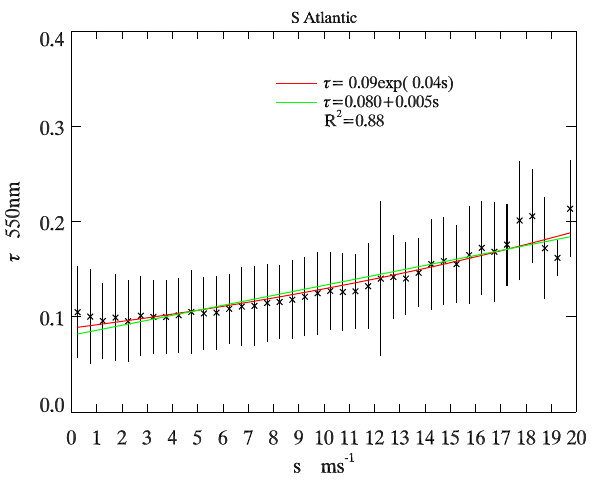
Fig. 7. Relationship between wind speed s and AOD τ over the